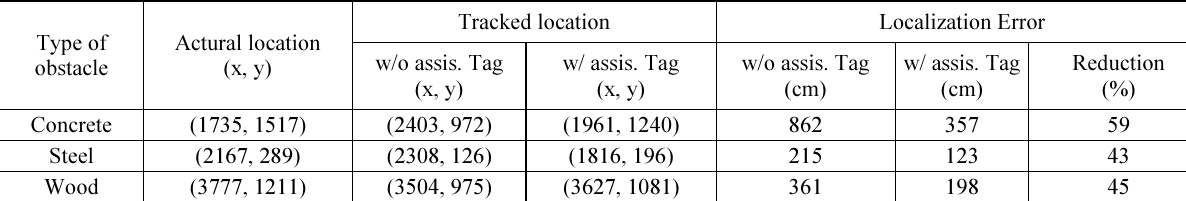
Table 6. Reduction of localization error in an NLOS environment with assistant tag Type of obstacle